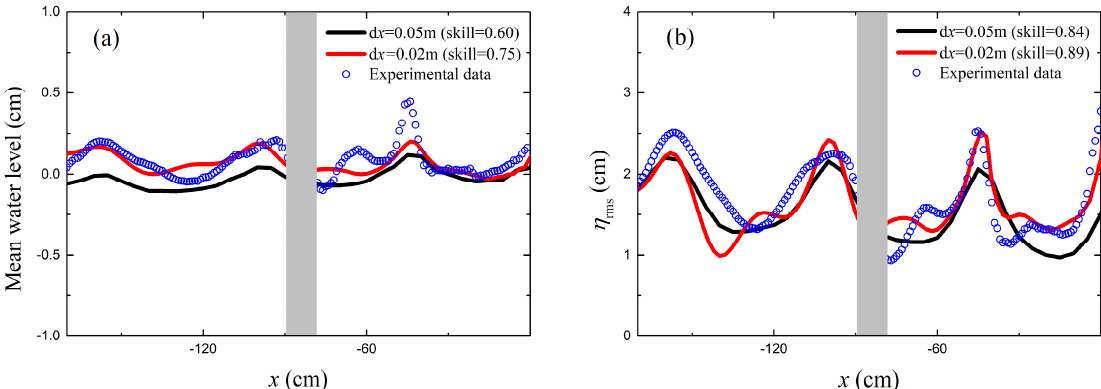
Figure 5. Comparisons of predicted and measured spatial distribution of ( a ) mean water level and ( b ) η rms for the wave case with H i = 5.5 cm, T i = 1.2 s, h s = 4.5 cm.